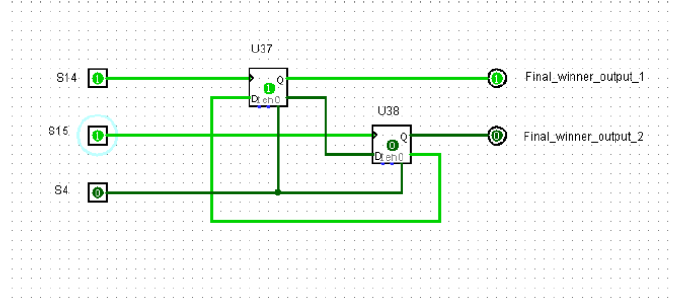
Figure A5. Result circuit (Logisim).